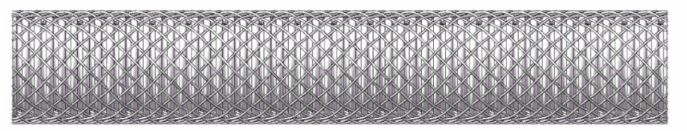
Figure 8. Geometry model of DN25 braided corrugated